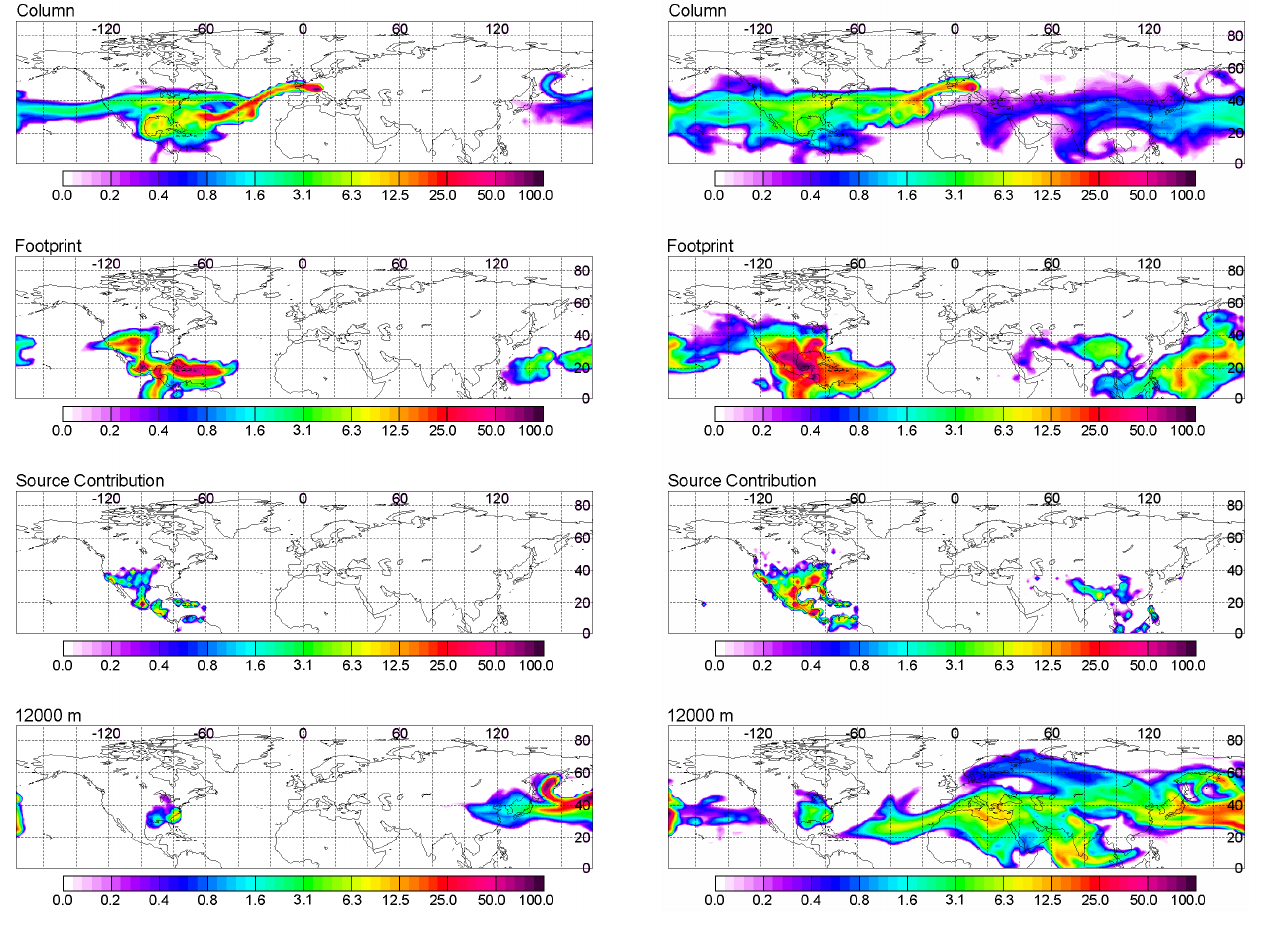
Fig. 3. Same as Fig. 2, but for the altitude range 7 to 10kma.s.l. above